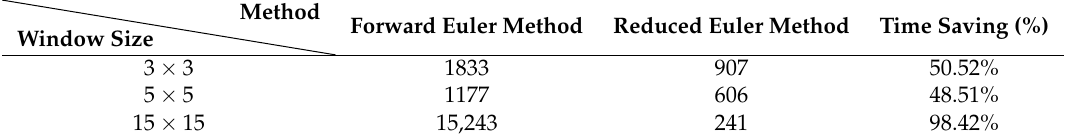
Table 5. Comparison of runtimes (in seconds) to compute the optical-flow between two frames by the forward Euler method and the reduced Euler method.